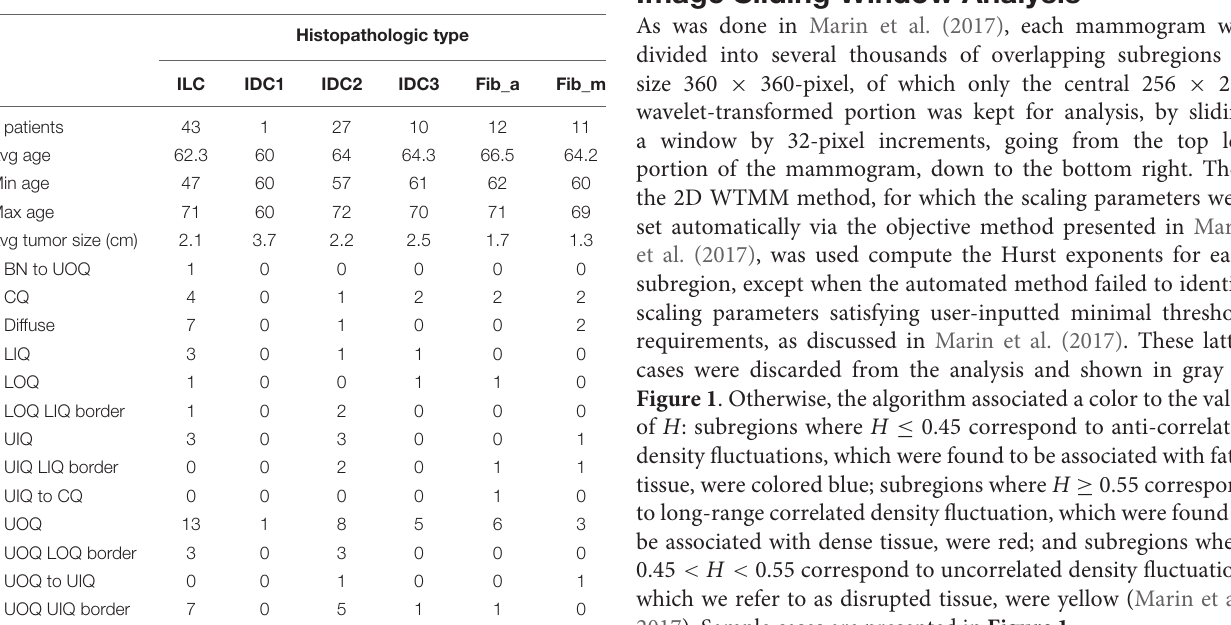
TABLE 1 | Study design and